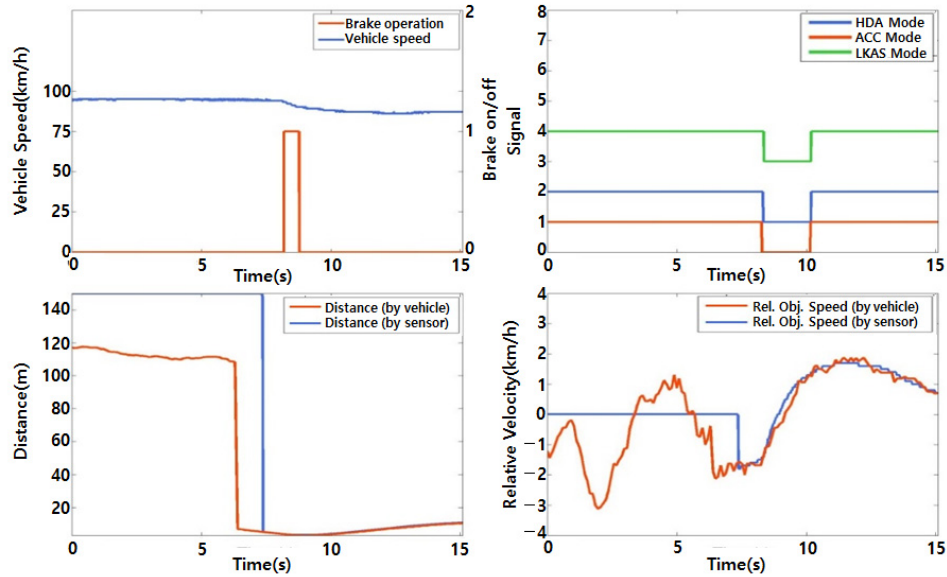
Figure 4. Preliminary data analysis for case 1.